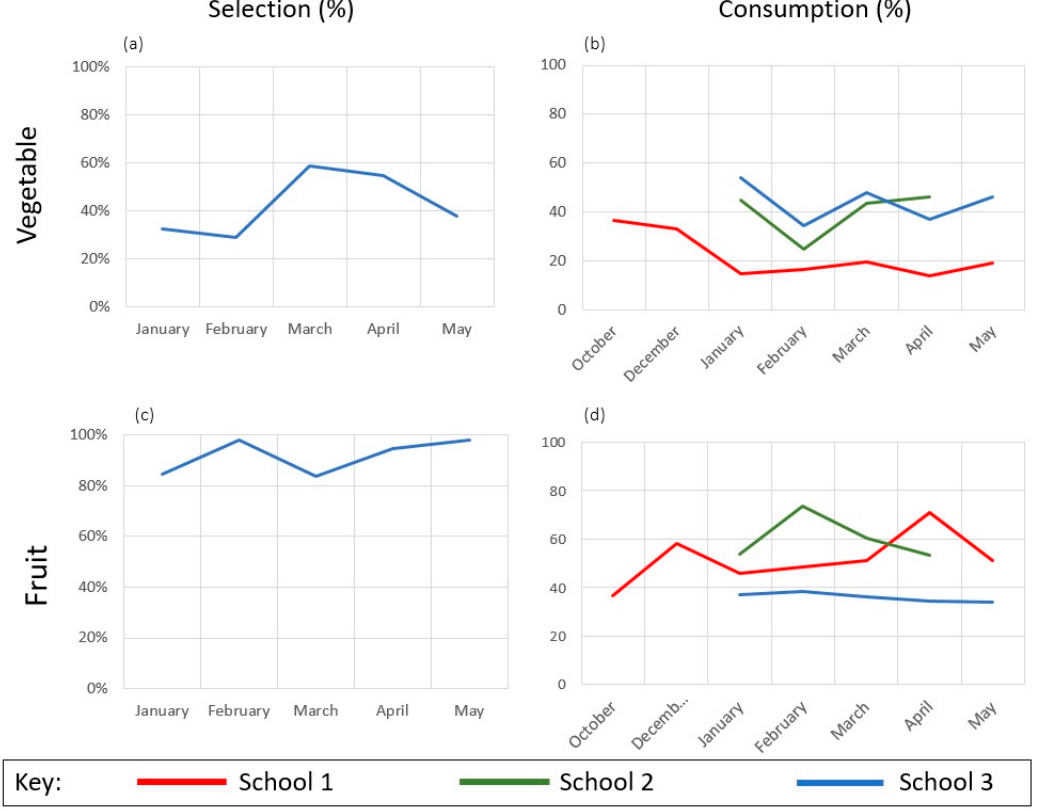
Figure 2. Monthly percent of fruit and vegetable selection and consumption. Note. Original selection frequencies displayed for vegetable ( a ) and fruit ( c ) components (for School 3 only). Estimated marginal means (adjusted for gender, grade, entrée consumption, and fruit offering) displayed for consumption of vegetable ( b ) and fruit ( d ).